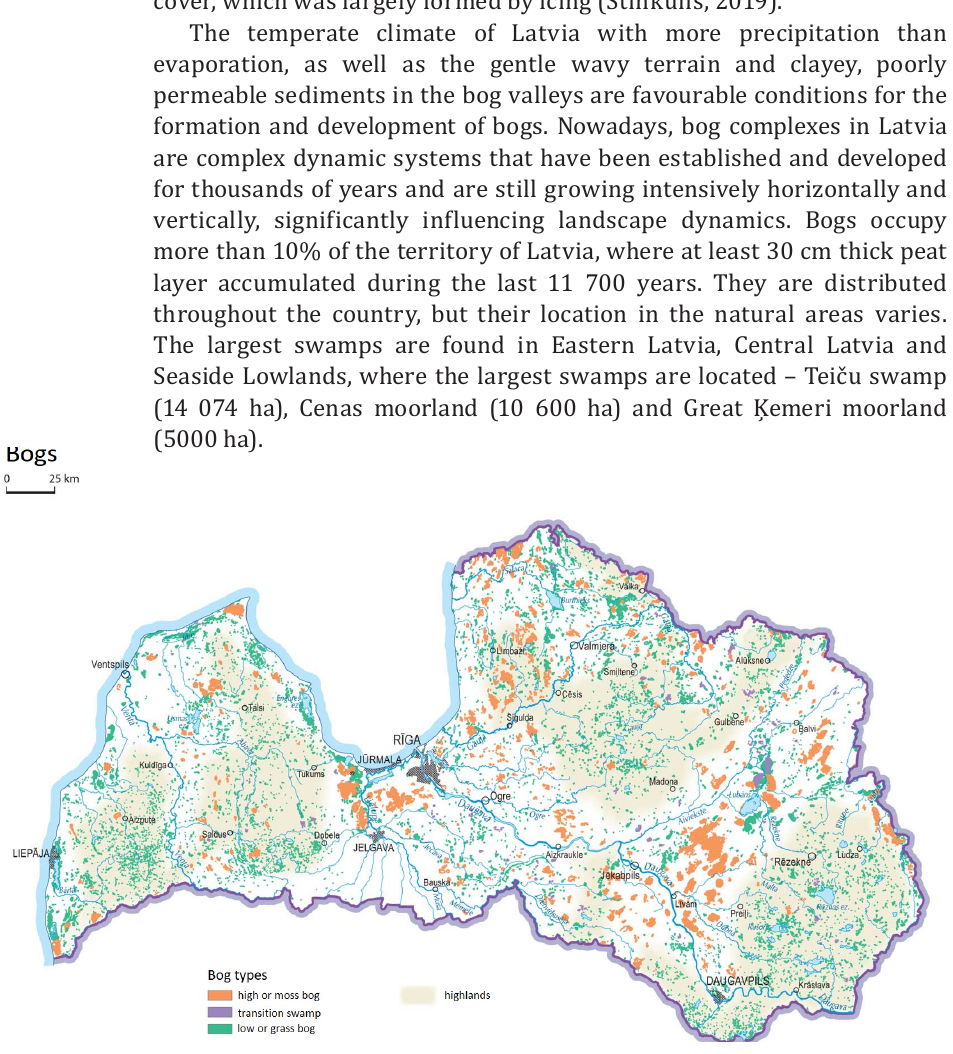
Figure 1. Bog distribution in the territory of